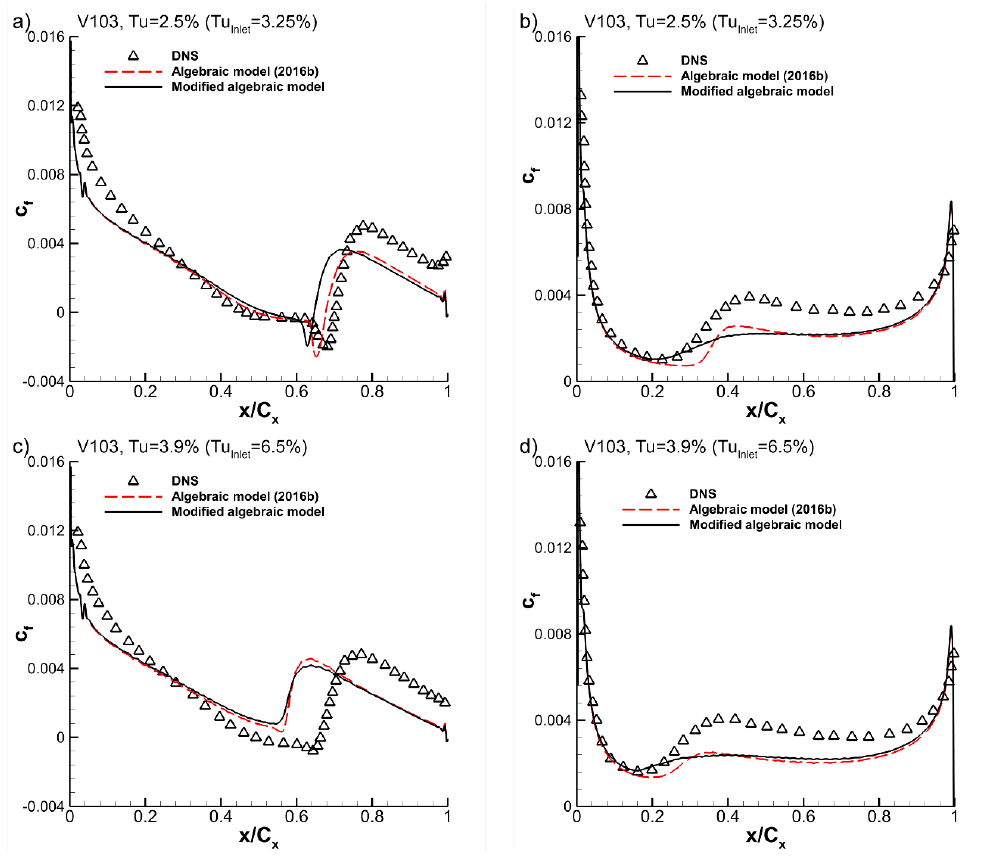
Figure 12. V103 compressor cascade. Skin friction coefficient on the suction ( a , c ) and pressure ( b , d ) sides for Tu =2.5% ( a , b ) and Tu = 3.9% ( c , d ).